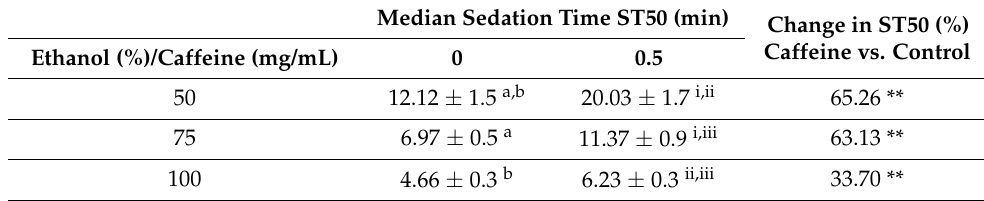
Figure 1. Effect of caffeine supplementation on ethanol-induced sedation in w 1118 flies. Comparison of ST50 when exposed to 100% ethanol of 1–3 day old male (circles) and female (triangles) w 1118 flies raised for three days at different dosages (0.25, 0.5, and 1 mg/mL) of caffeine-supplemented food. Both male and female w 1118 flies raised on 0.5 mg/mL caffeine-supplemented food have a significantly higher ST50 than control flies. Horizontal bars represent the mean ST50 ± standard error of 15–19 biological replicates. For each sedation assay 8–10 male flies were used. *** p = 0.001; ANOVA, post hoc Tukey HSD. Table 1. Effect of caffeine on sedation at different ethanol concentrations.